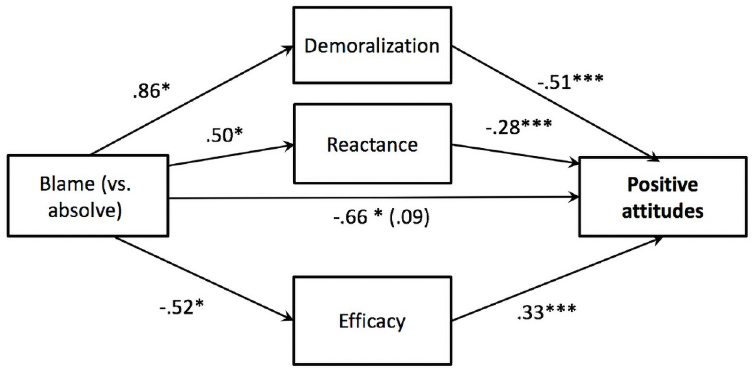
Fig 3. Model testing the effect of condition (blame vs. absolve) on positive attitudes towards veg � nism through demoralization, reactance, and efficacy beliefs for Study 3. Note . Unstandardized coefficients displayed. � p < .05, �� p < .01, ��� p < .001, one-tailed tests.